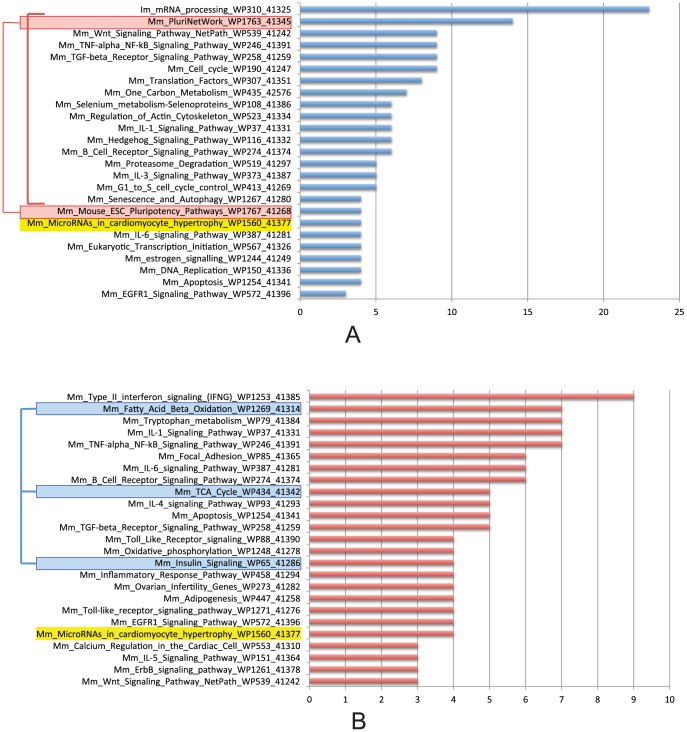
Overrepresented pathways for P10.5 and P18.5.A. The top 25 overrepresented pathways in P10.5, where modules in this class have their highest level of expression at E10.5. Pathways in red boxes are pluripotency-related pathways enriched in P10.5 modules; pathways highlighted in yellow are also enriched in P18.5. B. The top 25 overrepresented pathways in P18.5, where modules in this class have their highest level of expression at E18.5. Pathways in blue boxes are metabolism-related pathways enriched in P18.5 modules; pathways highlighted in yellow are also enriched in P10.5.